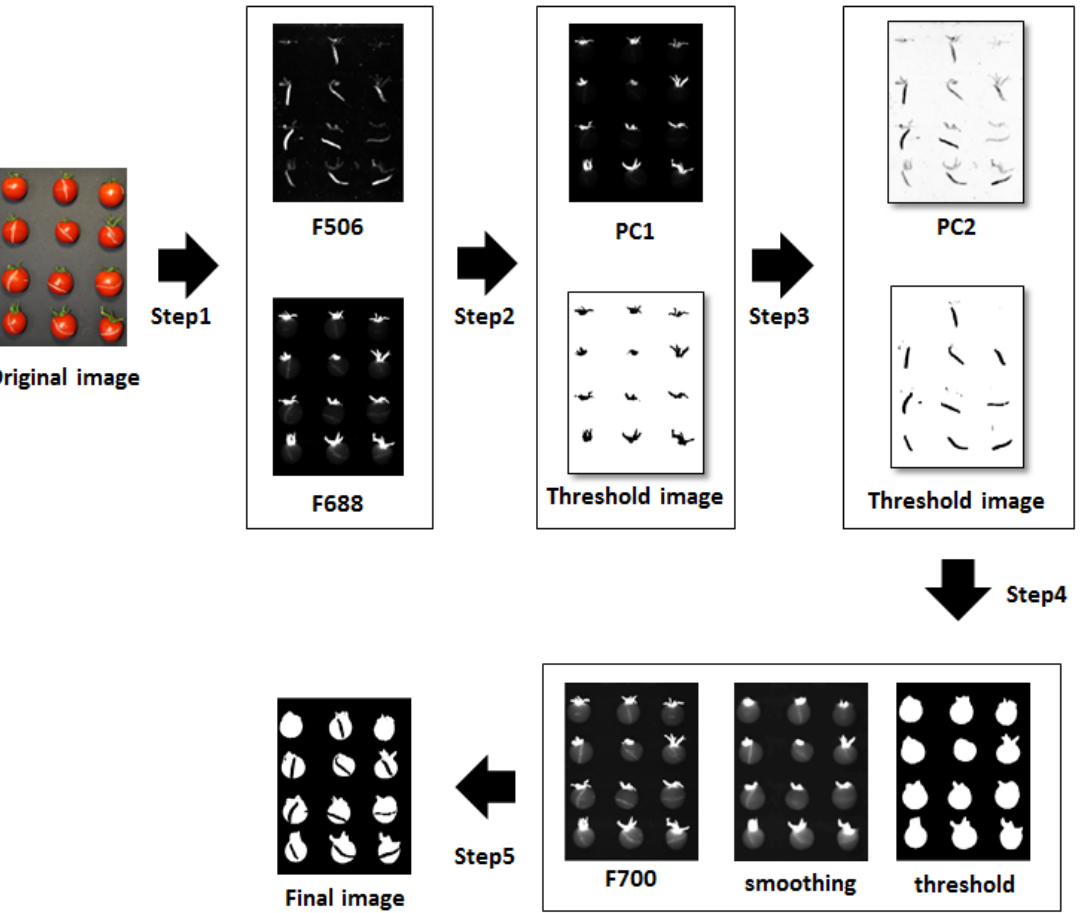
Figure 10. Image processing for detecting defects of cherry